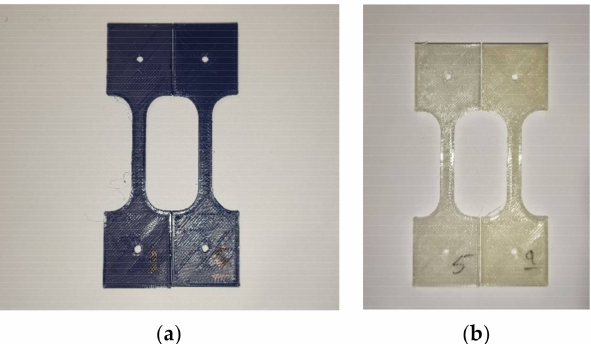
Figure 3. Changes in material color and reflectivity, ( a ) PLA part comparison between control group (left) and treatment group (right); ( b ) PETG part comparison, control group (left) and treatment group